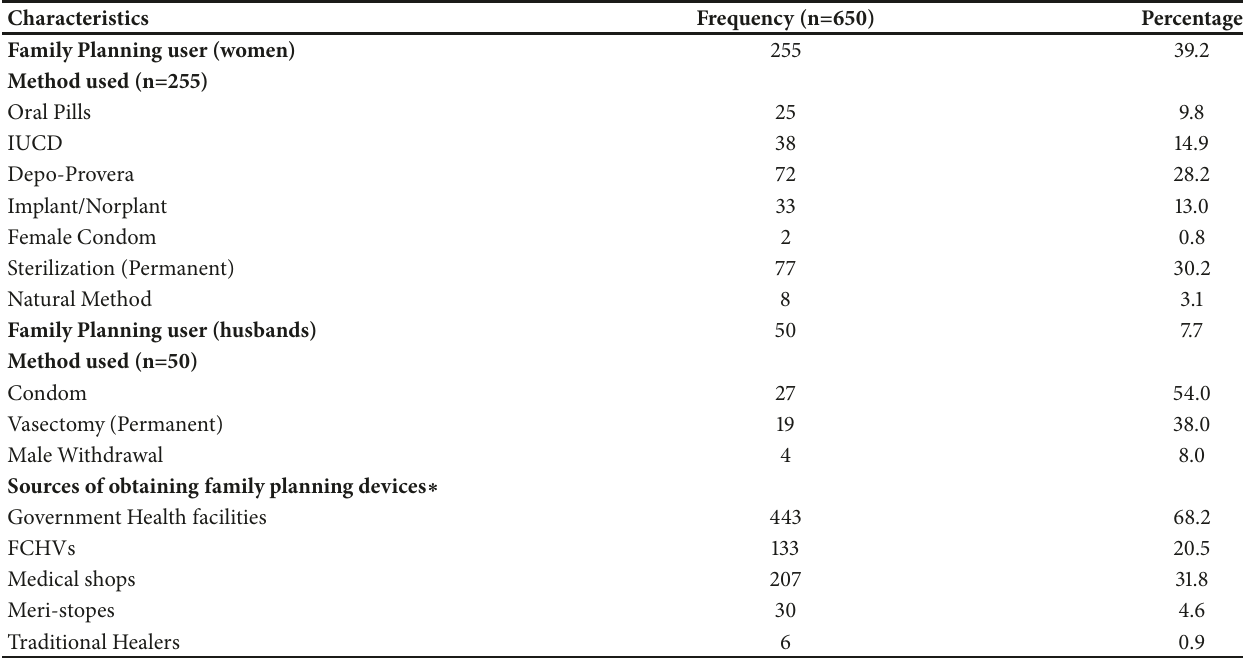
Table 2: Distribution of family planning method-related characteristics of study population.